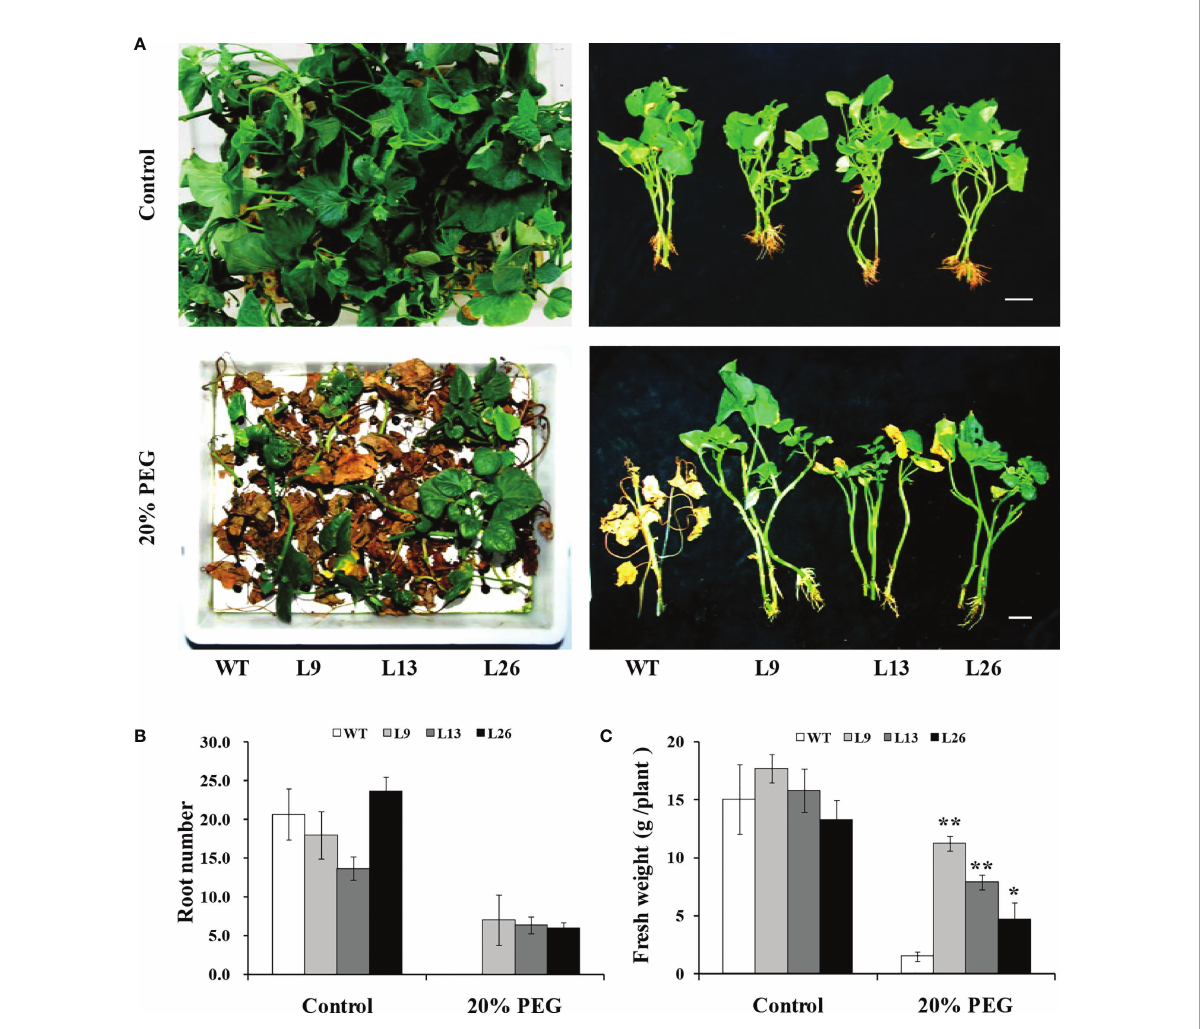
FIGURE 4 Responses oftransgenicsweet potato plants and WT treated in Hoagland solution for 4 weeks(control) orin Hoagland solution with 20% PEG6000 for 2 weeks followed by 2 weeksofHoagland solution. (A) Phenotypes. (B) Root number. (C) Freshweight. * and **indicate signi fi cant differences from that of WT at P <0.05 and P <0.01, respectively, accordingtoStudent ’ s t